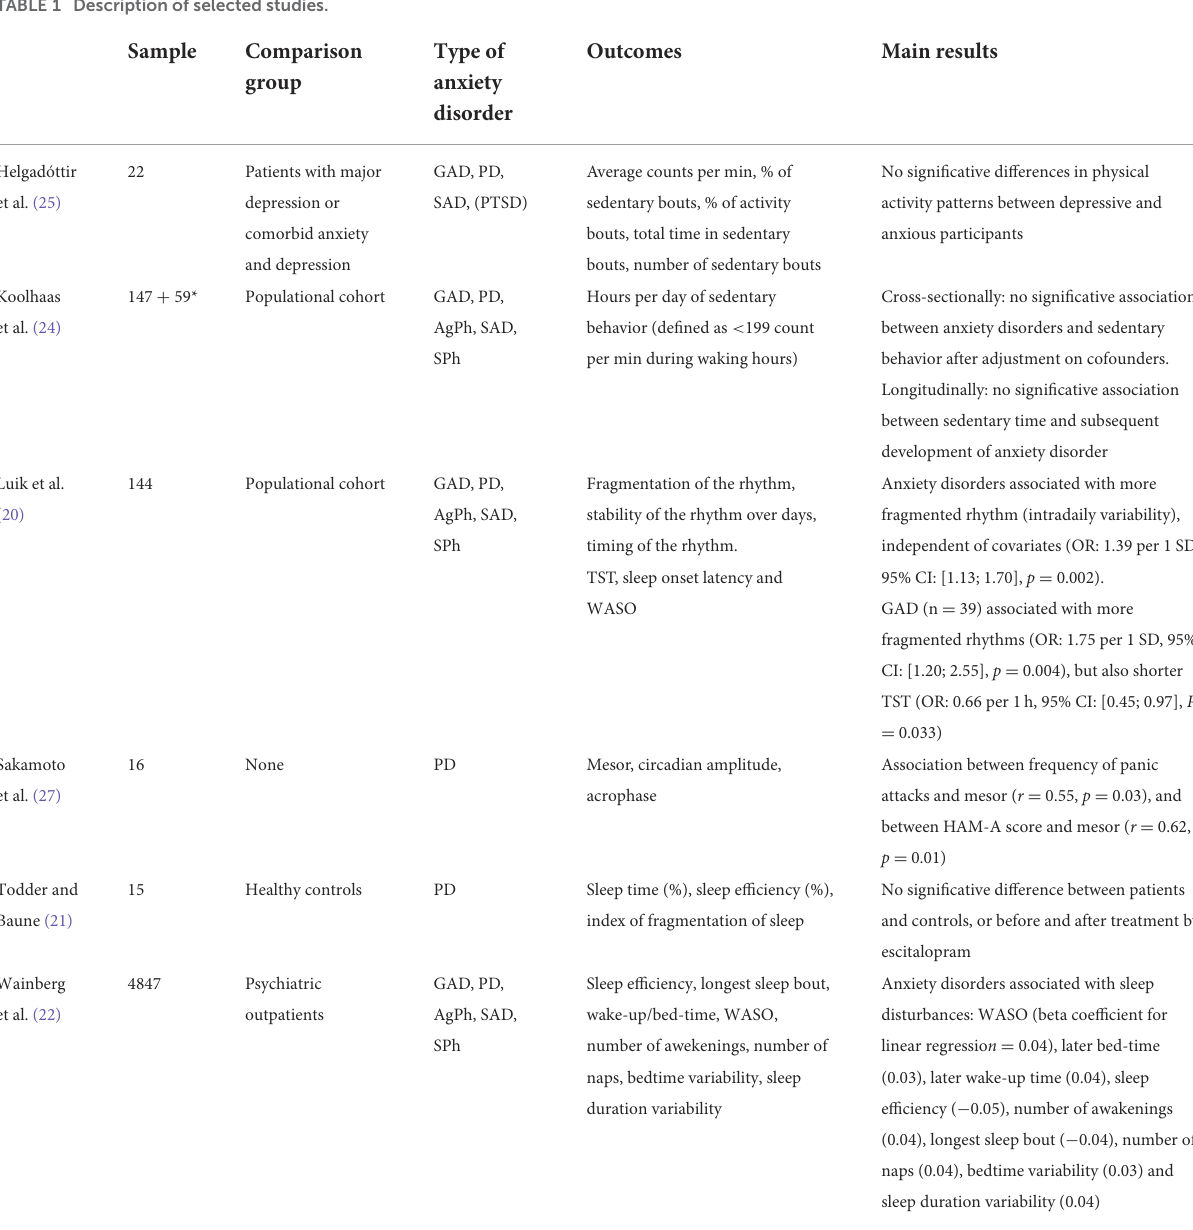
TABLE 1 Description of selected